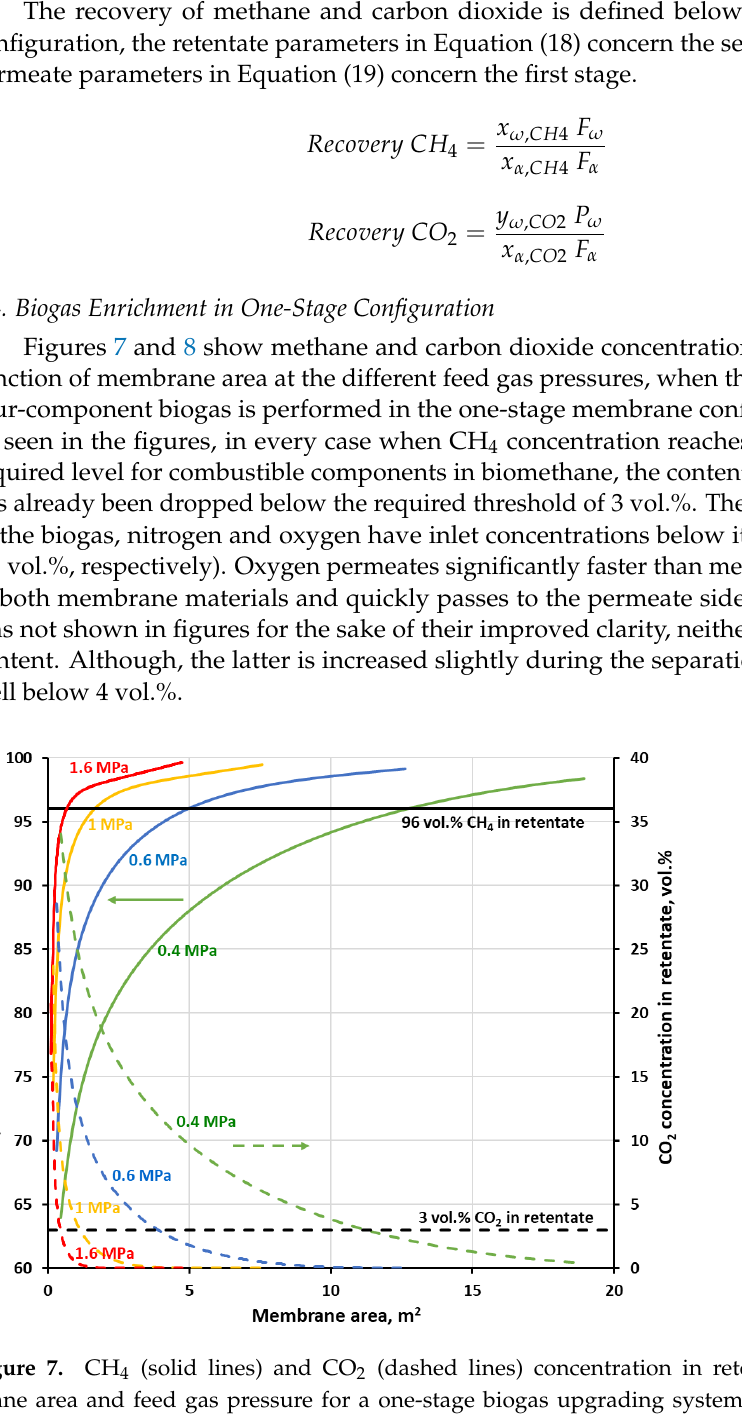
Figure 8. CH 4 (solid lines) and CO 2 (dashed lines) concentration in retentate against membrane area and feed gas pressure for a one-stage biogas upgrading system with the polysulfone (PRISM PA1020) membrane. The recovery of methane which is associated with 96 vol.% of CH 4 on the concentra- tion profiles in Figure 7; Figure 8 is equal to 53.4, 82.5 and 88.6% at 0.4, 1 and 1.6 MPa, respectively, for the polyimide membrane and 30, 61.8 and 71.6% at 0.4, 0.8 and 1.2 MPa, respectively, for the polysulfone one. At the highest pressures, this recovery is in line with theoretical data concerning the trade-off between CH 4 purity and CH 4 recovery, reported by Scholz et al. [19] for the separation of 50% CO 2 and 50% CH 4 . Methane recovery is presented in Figure 9; Figure 10 as a function of membrane area at the different feed gas pressure along with carbon dioxide concentration and recovery in permeate. The val- ues of CH 4 recovery at higher pressures are thus acceptable in the case of the one-stage